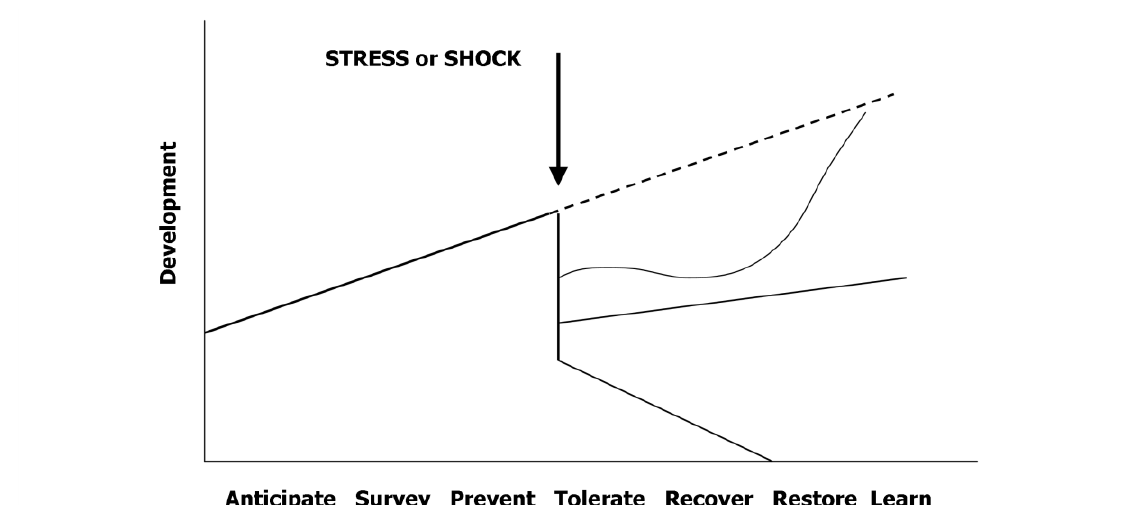
Figure 1. Agricultural development model of resilience. Note: A similar diagram was used in IRISS Deliverable 6.1, and was adapted from The Montpellier Panel (2012, p.